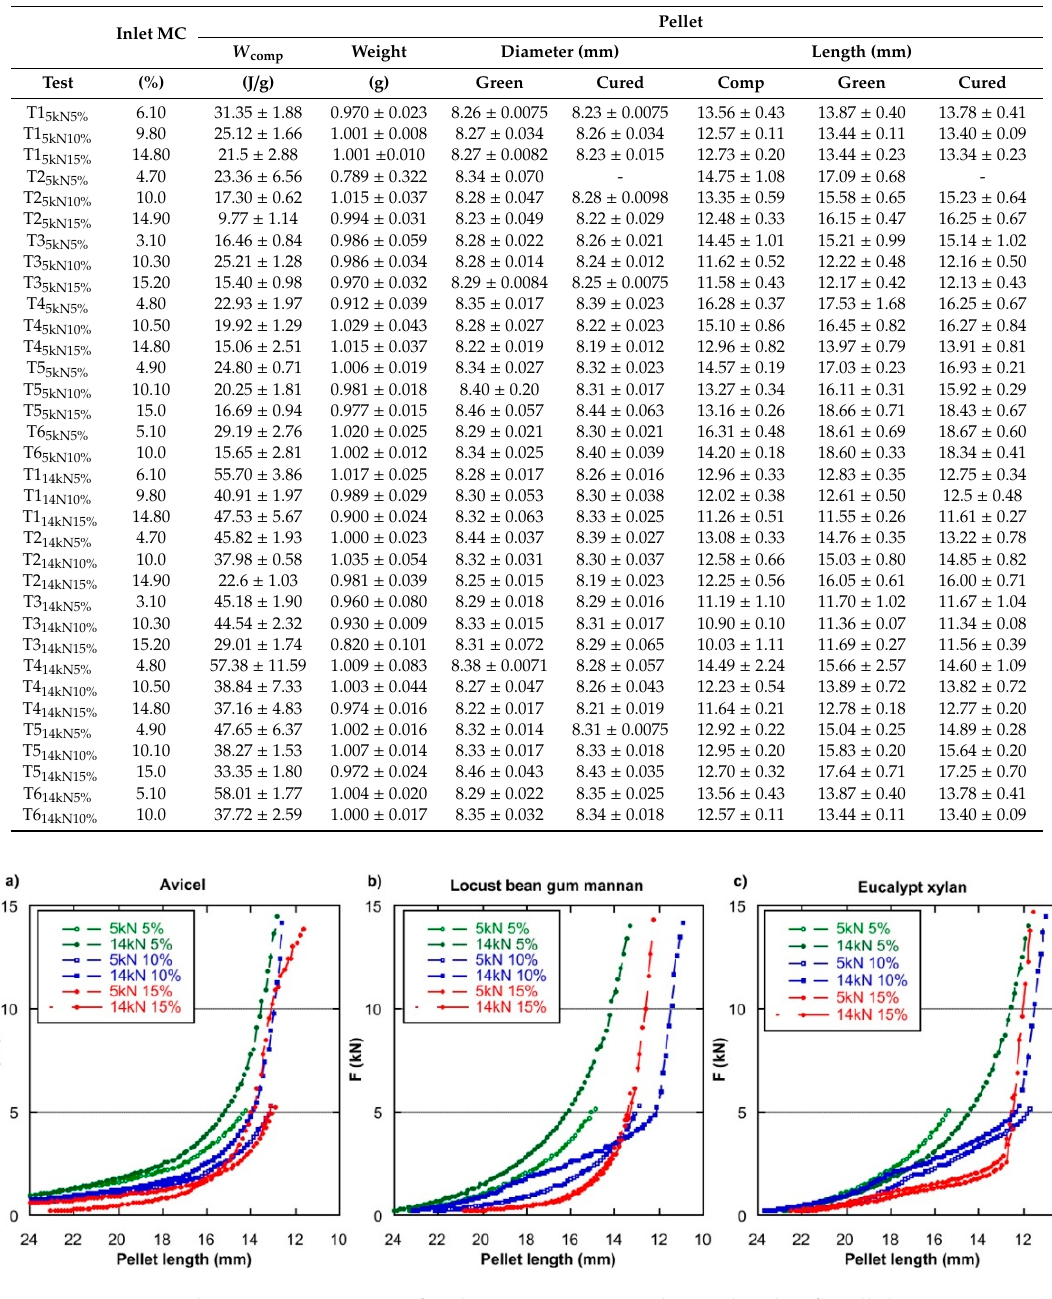
Figure 4. Typical compression curves for three test series at 5 kN and 14 kN for all three moisture contents were ( a ) are Avicel, ( b ) Locust bean gum mannan and ( c ) Eucalypt xylan.